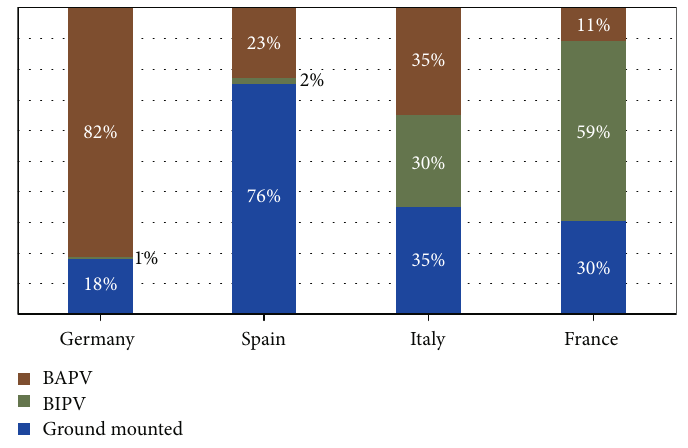
Figure 5: Market share for the four European PV markets [12,